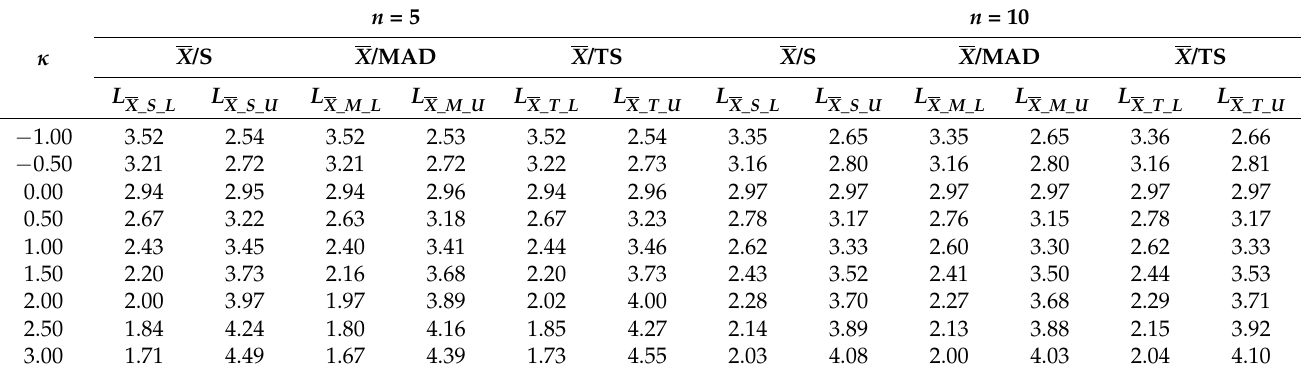
Table 3. Constants of the WV mean charts with different n and κ of a Weibull